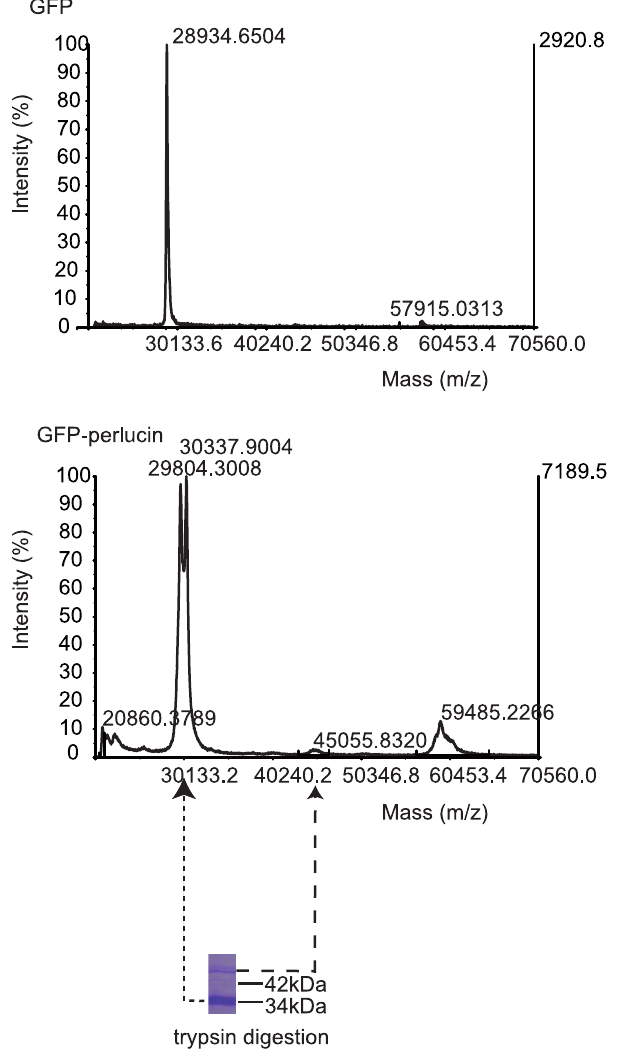
Table 1. MALDI-TOF/TOF (MS + MS/MS) identification of GFP- perlucin (46.8